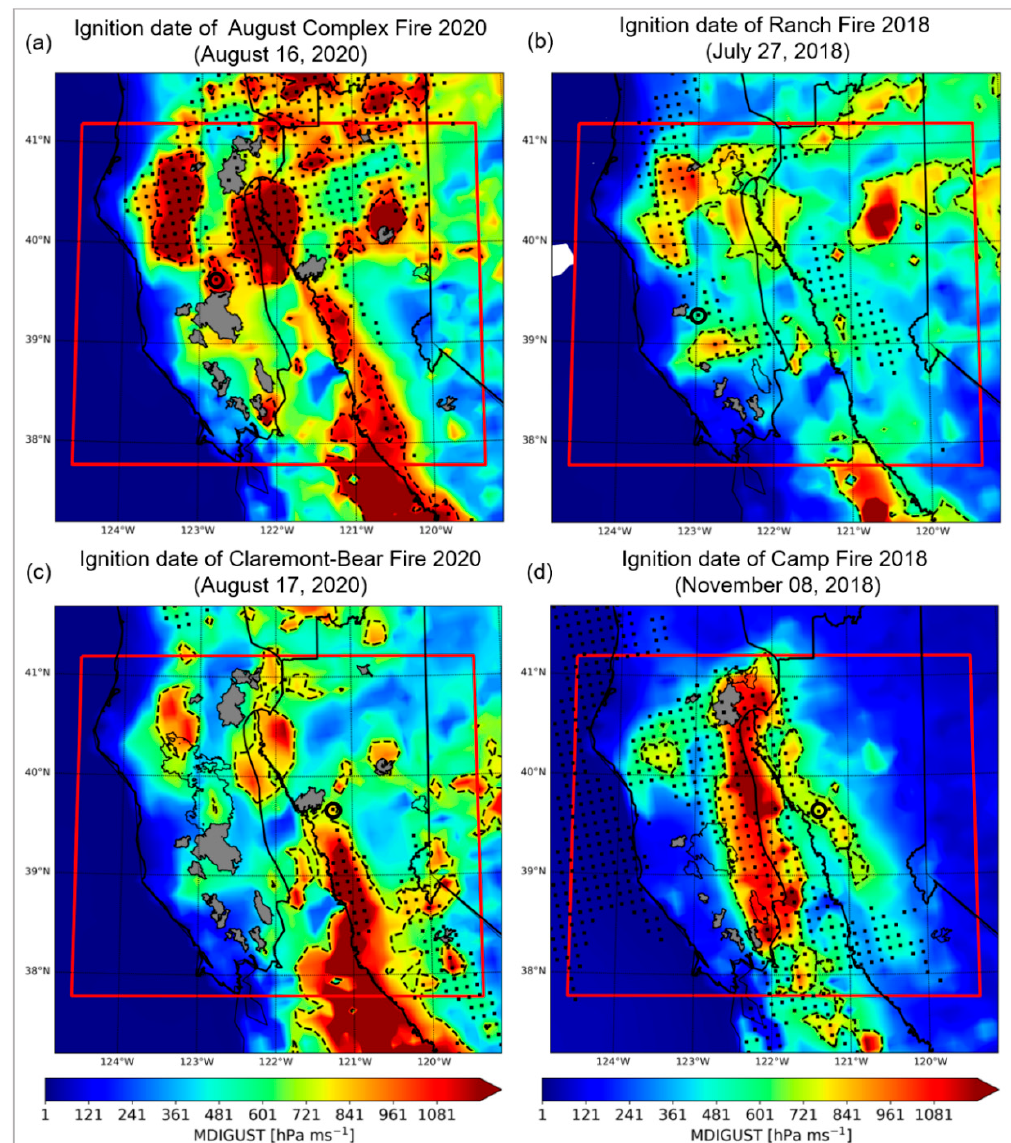
Figure 3. Spatial distributions of daily averaged MDIGUST on the ignition date for each wildfire. ( a ) August Complex Fire 2020, ( b ) Ranch Fire 2018, ( c ) Claremont-Bear Fire 2018, and ( d ) Camp Fire 2018. Gray-filled areas represent the burned areas of the wildfires that occurred before and had already been contained on the ignition date. Unfilled wildfire perimeters are the burned areas of the wildfires that were still active (not fully contained) on the ignition date. Black square dots are the grid points whose daily averaged MDIGUST peaked on the ignition date during the time period shown in Figure 2. Black dotted lines in Figure 2 show the contours of daily averaged MDIGUST that were equal to or greater than the 80th percentile of daily averaged MDIGUST in North Coast and Sierra Nevada on the ignition date. The ignition location grid point is enclosed in a black circle.